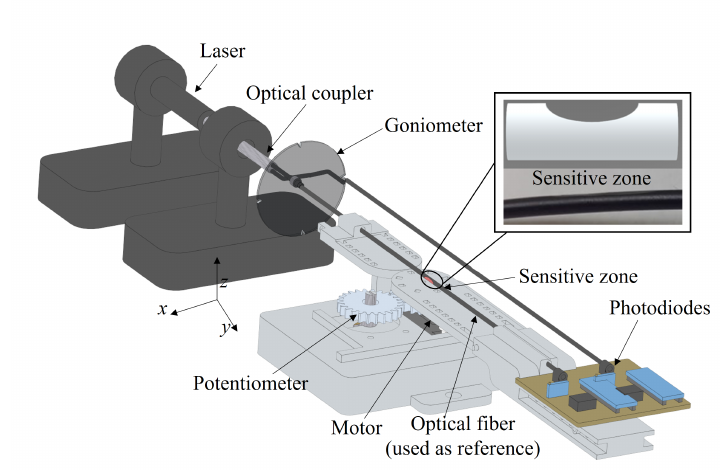
Figure 4. Experimental setup for the multiplane curvature